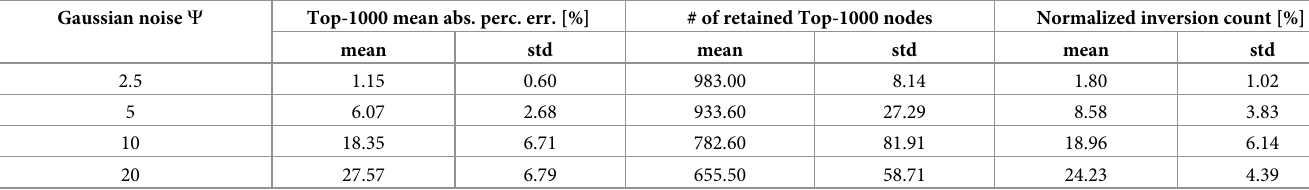
Table 5. Sensitivity of Brandes to different levels of random noise introduced on G 08:00 . Gaussian noise C Top-1000 mean abs. perc. err.